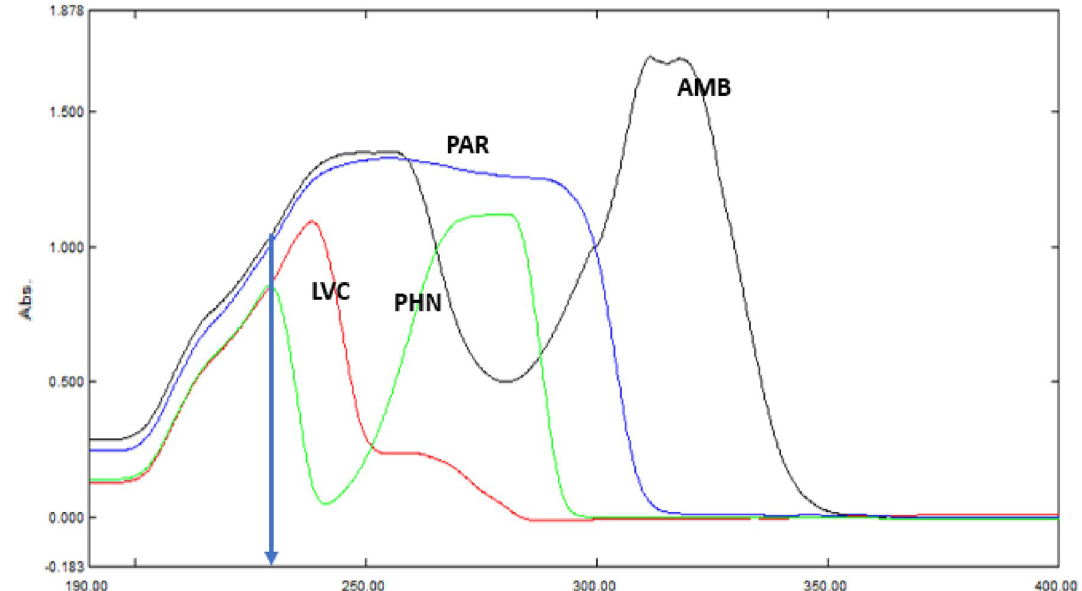
Figure 4. Absorption spectra of PAR, LVC, PHN and